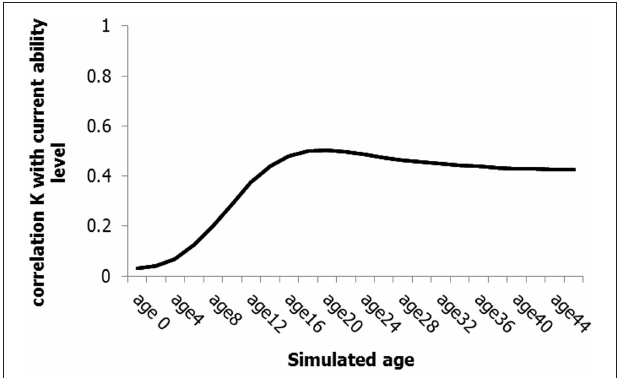
FIGURE 8 | Correlations between the K -parameter and the ability level at different simulated